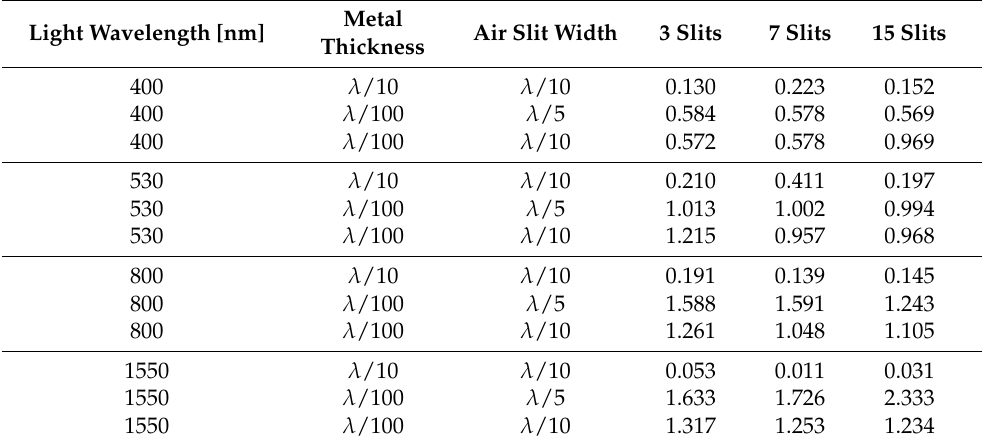
Table 4. Maximum absolute values of the normalized electric field along the intrinsic region for a platinum nanoantenna.